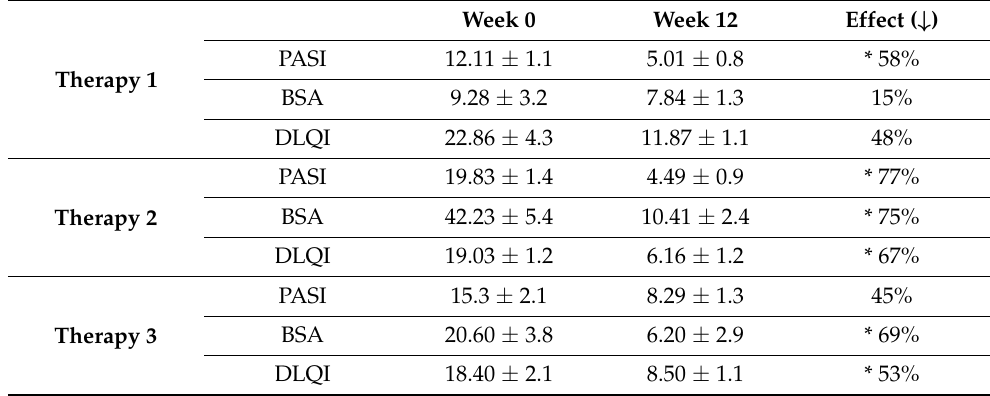
Table 5. The comparison of PASI, BSA and DLQI scores between therapies with: MTX (therapy 1, n = 20), anti-TNF α (therapy 2, n = 20), anti-IL17a (therapy 3, n = 10) in patients with plaque psoriasis at two measurement points (week 0, week 12). * indicates a statistically significant difference ( p < 0.05).